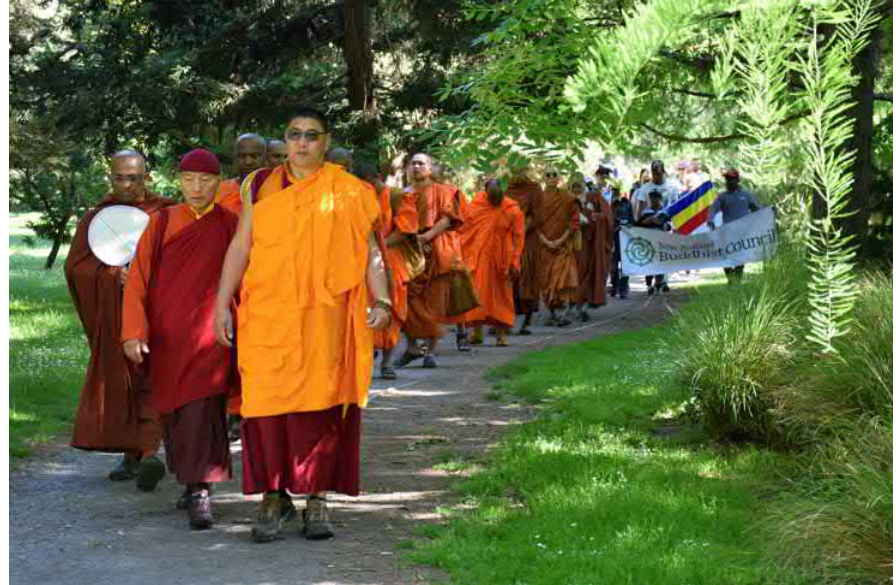
Figure 10: Buddhist Peace Walk held in 2018 in Ōtautahi/Christchurch, attended by Buddhist communities of the region, and representatives of the NZ Buddhist Council. (Photo by John